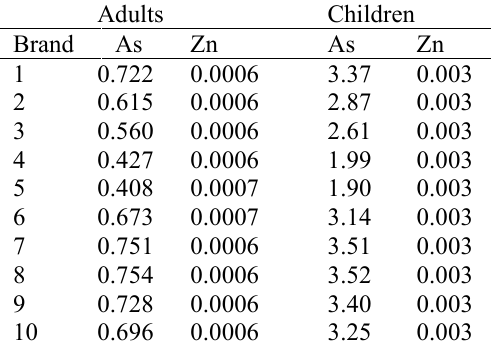
Table 3. Health risk index (HRI) for individual